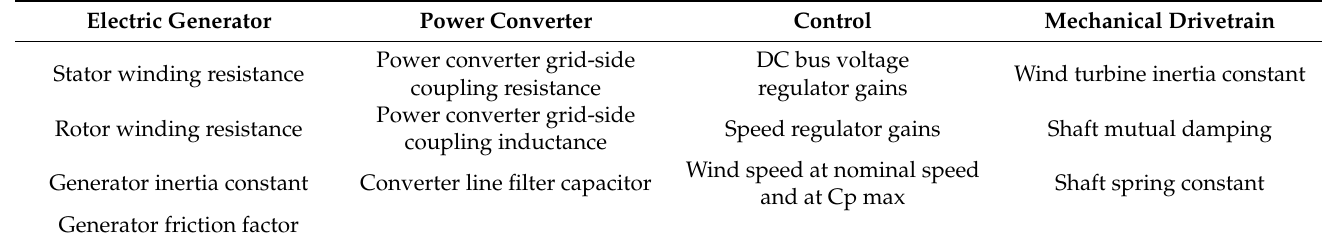
Table 3. Parameters involved in the optimization process.